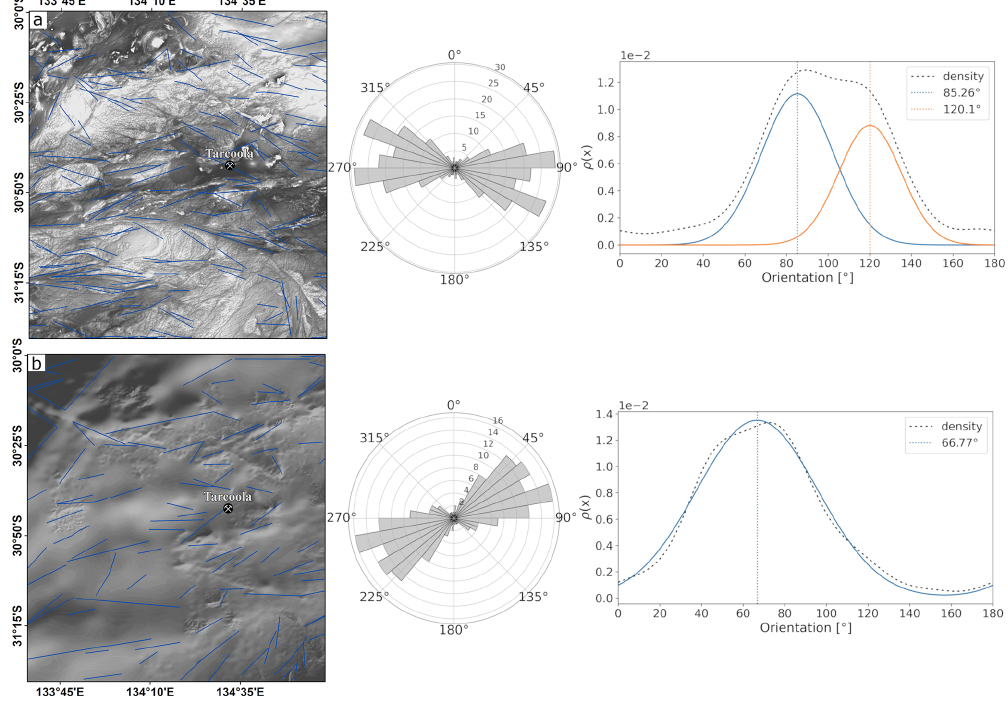
Figure 10. Lineaments automatically extracted with PCI Geomatica LINE module from the total magnetic intensity (reduced to pole) (a) and the gridded gravity data (b) . To the right of the maps the rose diagrams show the orientation distribution (bin size of 10 ◦ ) and the models fitted to the probability density of the empirical